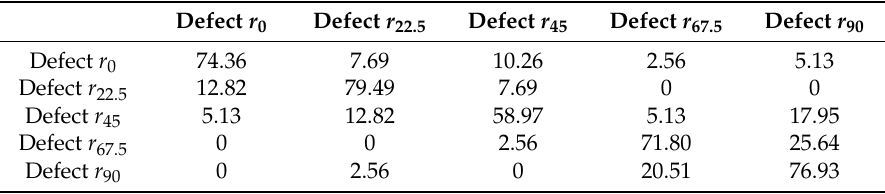
Table 3. Confusion matrix of the DCNN ROT (rotation) [%].